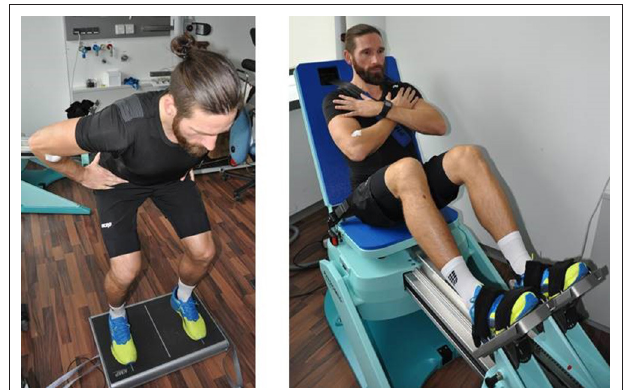
FIGURE 1 | Leg press test (hip/leg extensor, hip/leg flexor strength) conducted on an isokinetic device (CON-TREX LP, Physiomed, Laipersdorf,